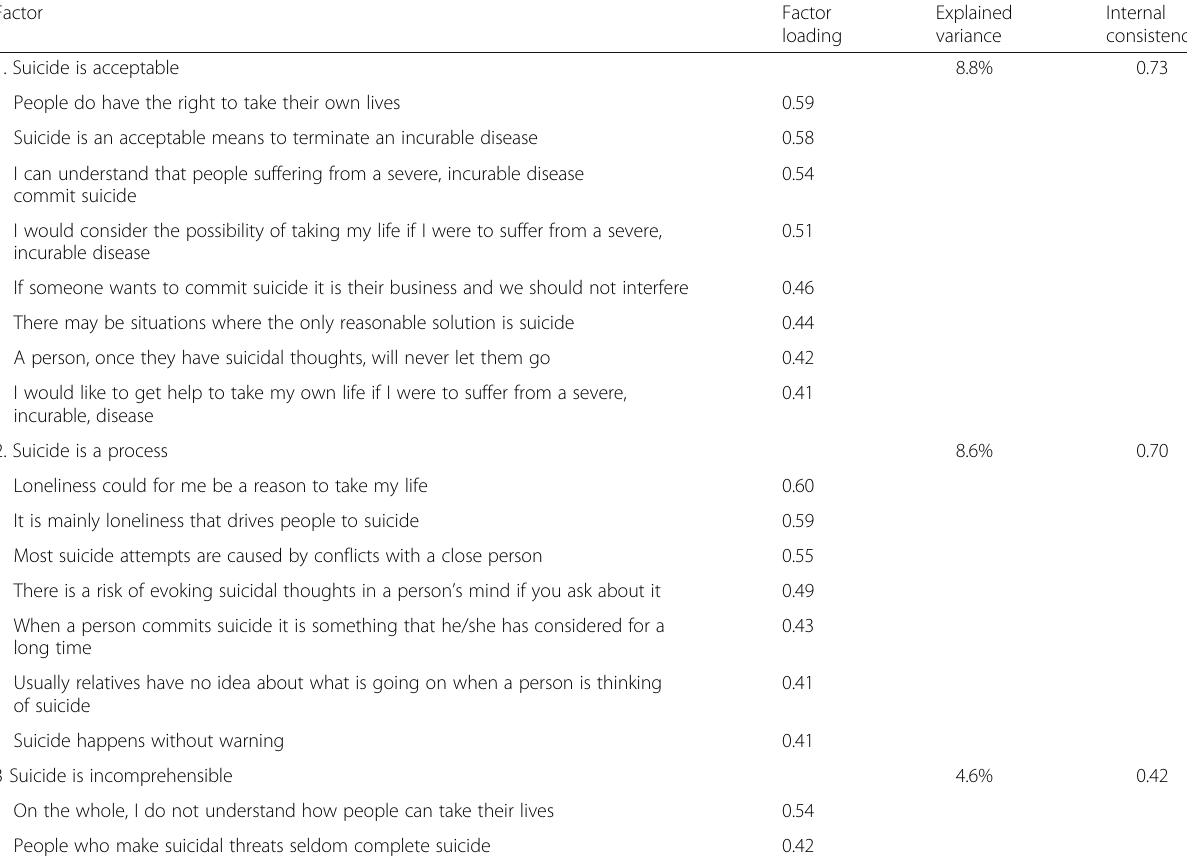
Table 5 Obtained factors, explained variance, items, factor loadings, and internal consistency of the ATTS